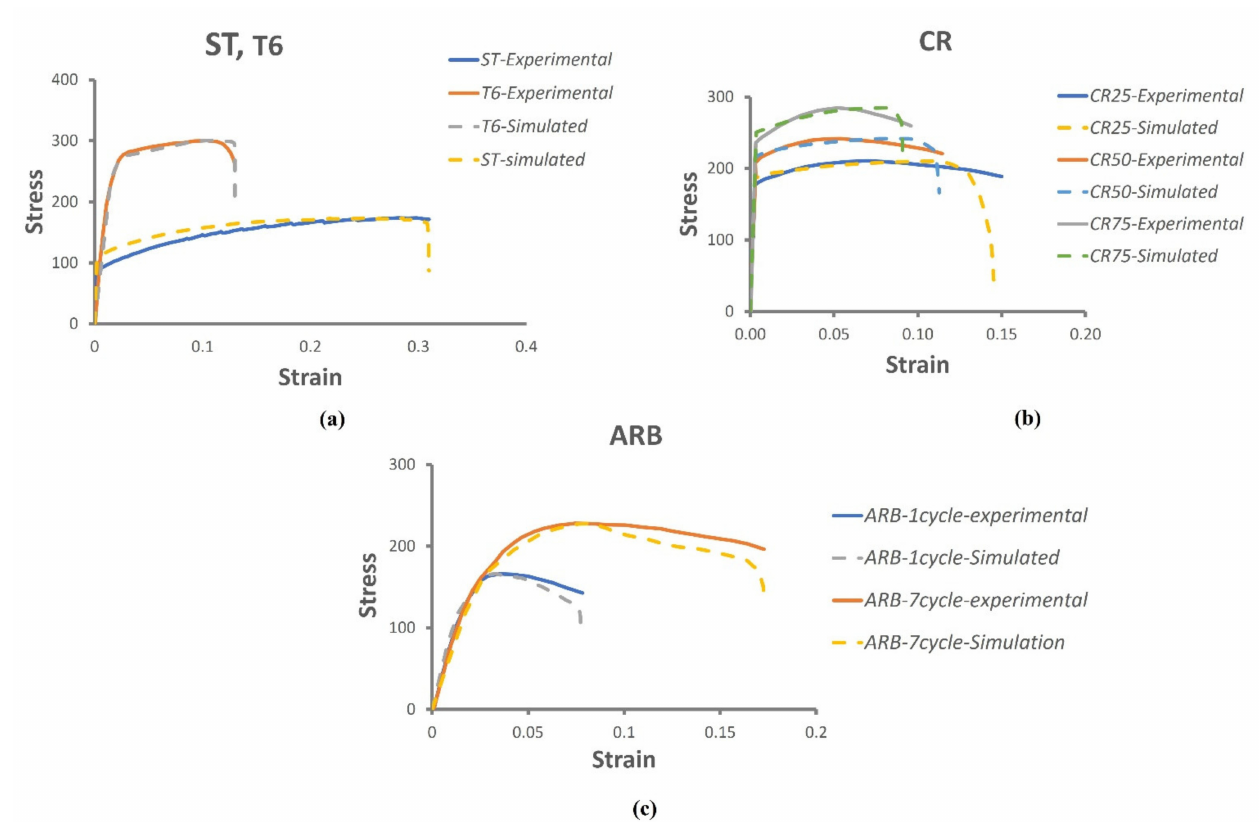
Figure 7. Stress–strain curve of Al6061 in ( a ) ST, T6 ( b ) CR ( c ) ARB condition. Flow